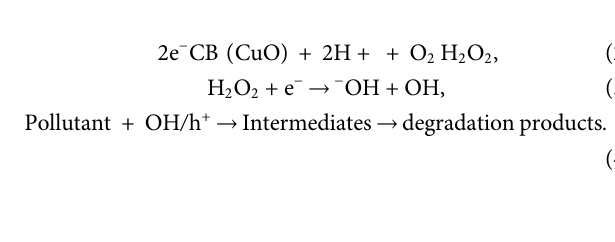
Frontiers in Chemistry |